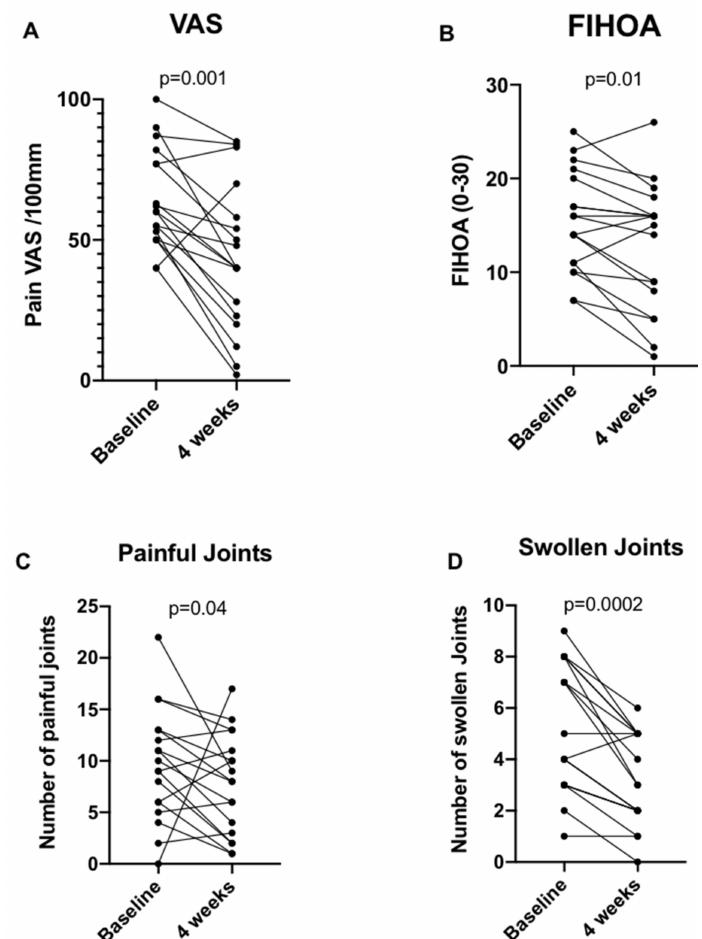
Figure 2. Effect of taVNS on EHOA symptoms. Evolution of ( A ) hand pain VAS on a 0–100 mm scale, ( B ) function evaluated by FIHOA, ( C ) number of painful joints (0–30), ( D ) number of swollen joints (0–30) of erosive hand osteoarthritis for each of the eighteen patients. Paired, non-parametric Wilcoxon t -test was used. Abbreviations: VAS, visual analog scale; FIHOA, Functional Index for Hand